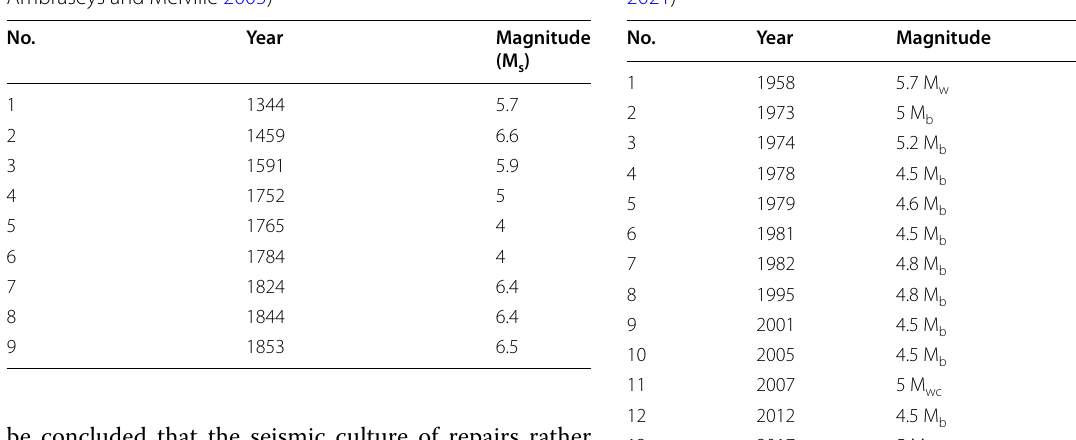
Table 2 Recent earthquakes near the city of Yazd (Source: